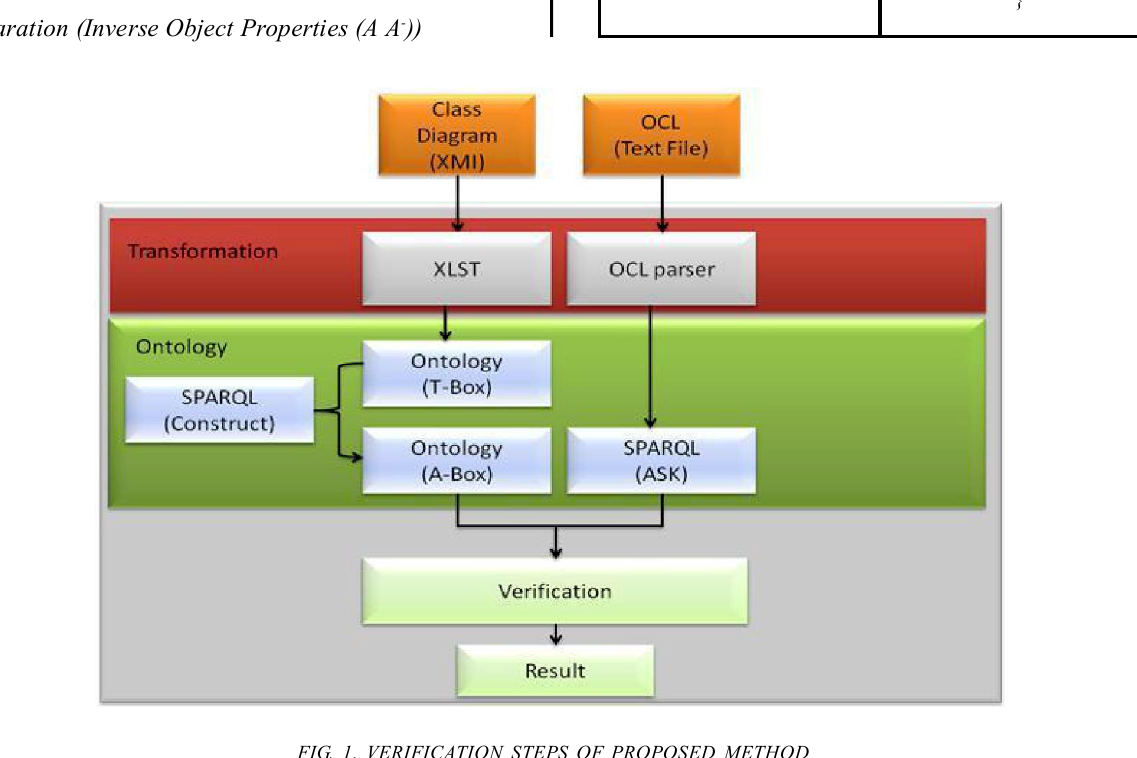
FIG. 1. VERIFICATION STEPS OF PROPOSED METHOD